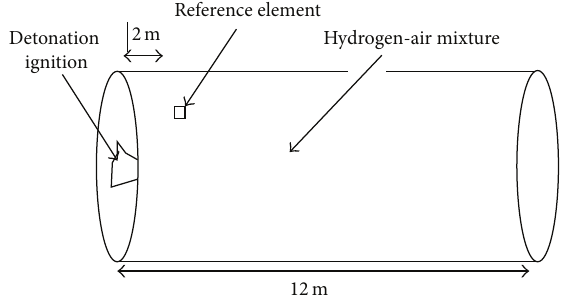
Figure 15: Schematic view of shock tube for exergy analysis